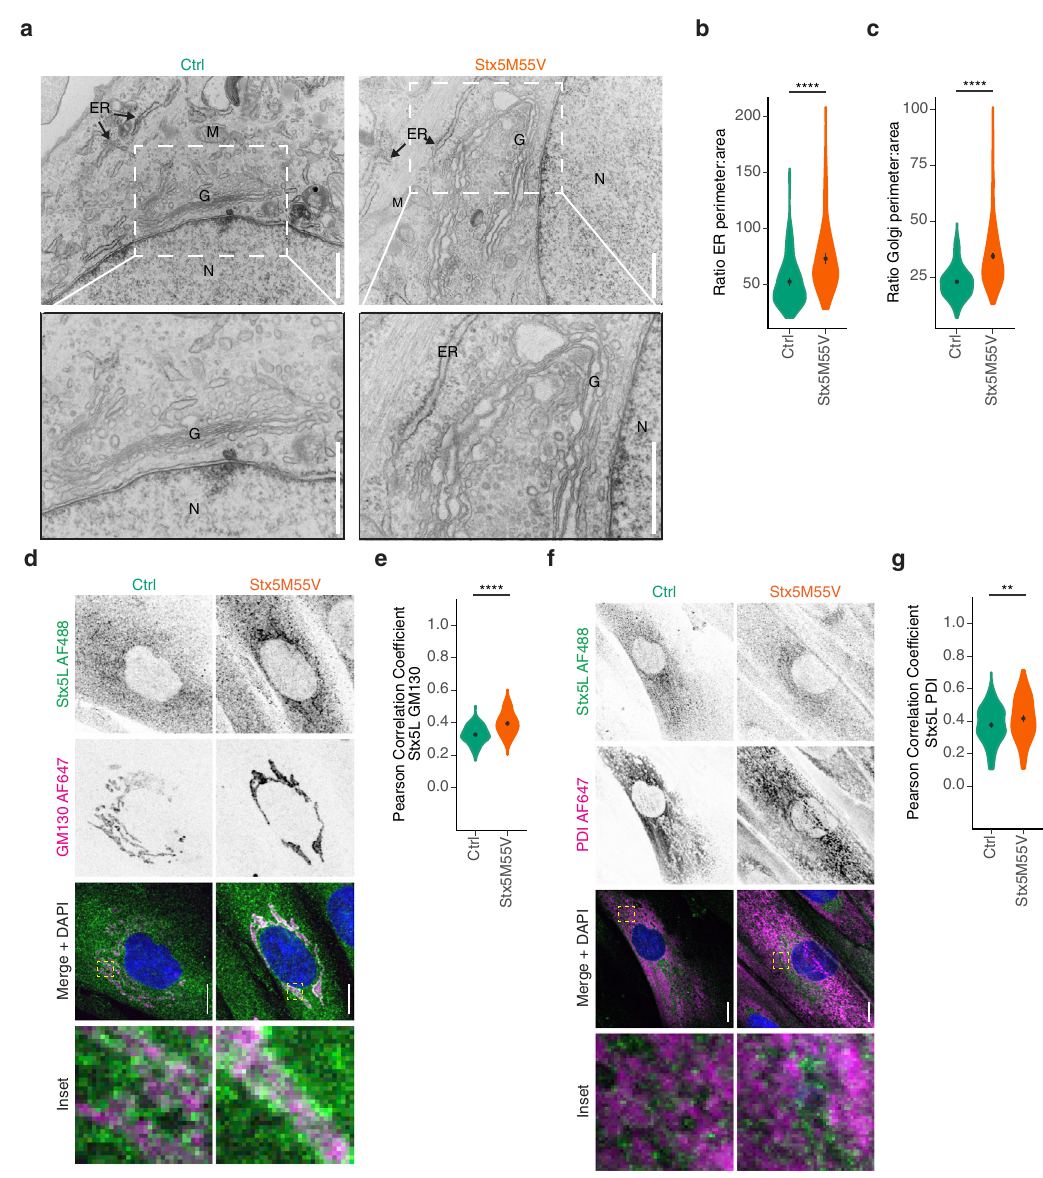
Fig. 4 Loss of Stx5S alters ER and Golgi morphology. a Representative transmission electron micrographs from healthy donor fi broblasts (left) or Stx5M55V patient fi broblasts (right). Scale bars, 1 µ m. N, nucleus; G, Golgi apparatus; ER, endoplasmic reticulum; M, mitochondrion. More electron micrographs in Supplementary Fig. 9. b ER perimeter and area quanti fi cation of panel ( a ), the ratios of the perimeters over the areas are plotted. N = 144 (both Ctrl and Stx5M55V) ER sections. Mean ± 95% CI. Unpaired two-sided Student ’ s t -test. **** P = 3.8 × 10 − 10 . c Same as panel ( b ), but now for Golgi. N = 400 (both Ctrl and Stx5M55V) Golgi sections. Mean ± 95% CI. Unpaired two-sided Student ’ s t -test. **** P < 2.2 × 10 − 16 . d Immuno fl uorescence microscopy of Stx5L (green in merge) and GM130 (magenta) in primary dermal fi broblasts of healthy donors (green, Ctrl) or Stx5M55V patients (orange, Stx5M55V). Representative confocal micrographs. Scale bars, 10 µ m. DAPI in blue. e Pearson ’ s correlations coef fi cients between Stx5L and GM130 of panel ( d ). N = 102 (Ctrl) and 135 (Stx5M55V) cells from 2 unique individuals tested twice. Mean± 95CI. Unpaired two-sided Student ’ s t -test. **** P = 9.45 × 10 − 14 . f , g Same as panels ( d , e ), but now for Stx5L (green) and TGN46 (magenta). N = 147 (Ctrl) and 156 (Stx5M55V) from 2